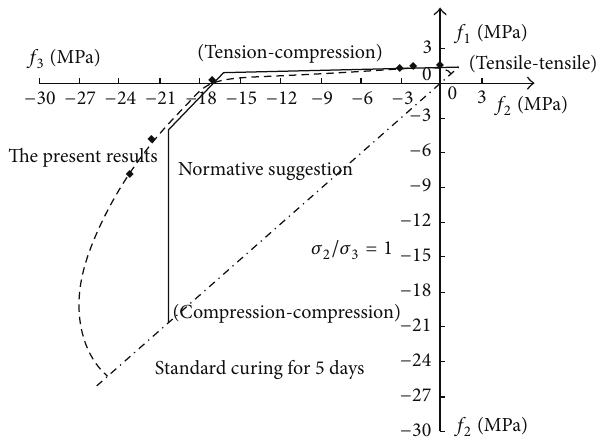
Figure 9: Biaxial ultimate strength envelope diagram of the C20 concrete after 5 d of standard curing.